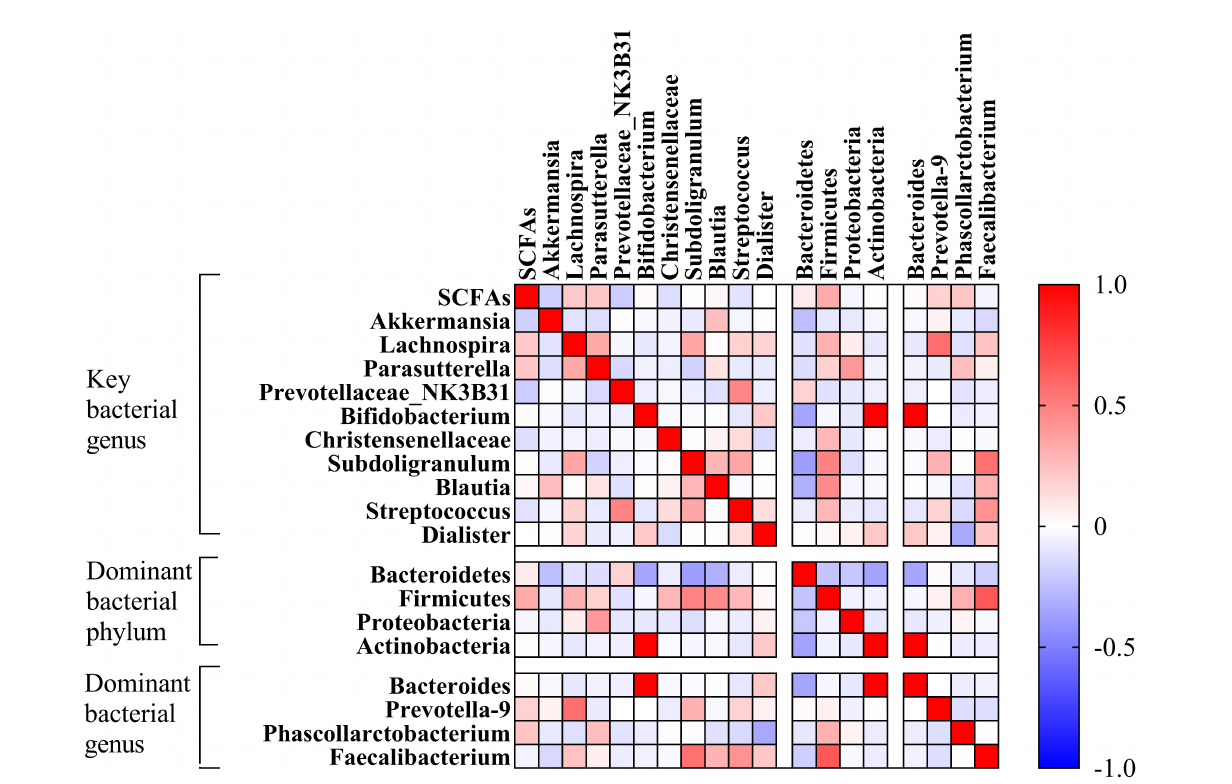
FIGURE9 Analysis of correlation between serum SCFAs content and intestinal flora. A positive correlation is red, and the deeper the red, the higher the positive correlation. A negative correlation is blue, and the deeper the blue, the higher the negative correlation. SCFA, short-Chain fatty